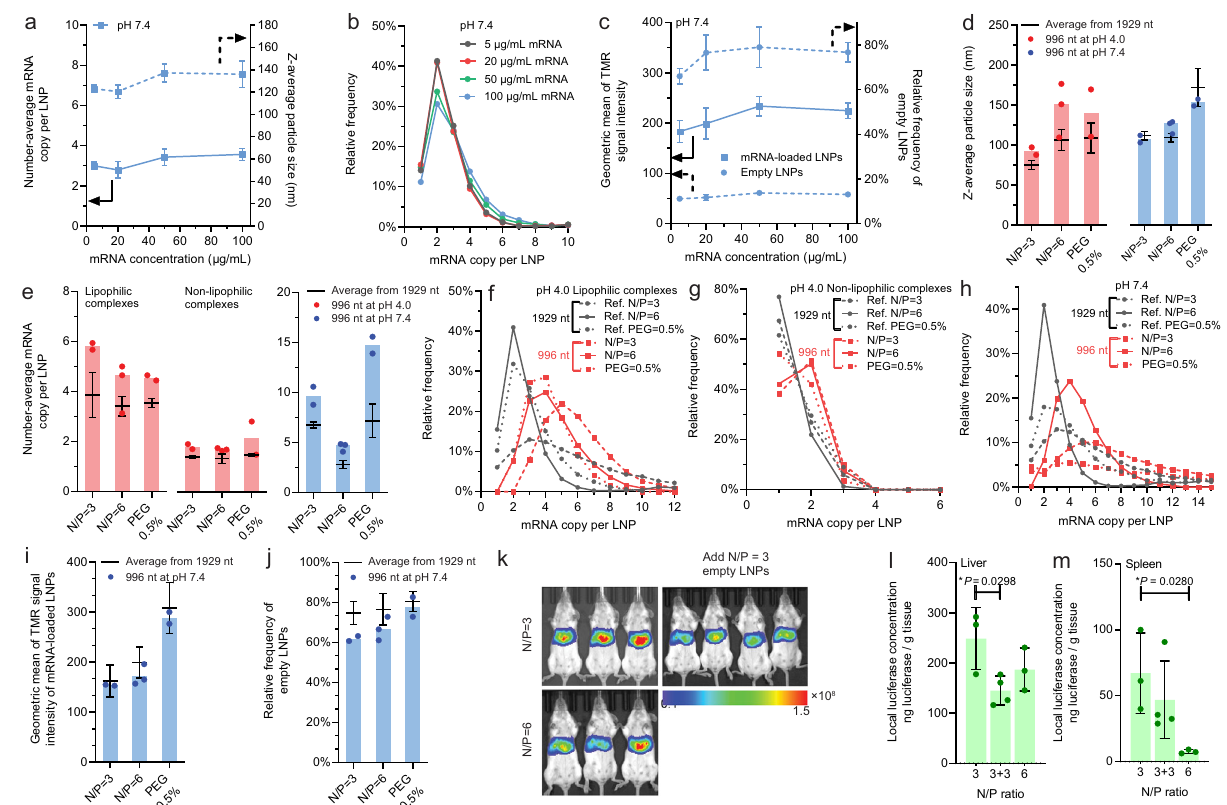
Fig. 7 | Effects of lipid and mRNA concentrations and mRNA size on payload capacity and distribution, and effect of empty LNPs on mRNA delivery ef fi - ciency. a – c The effect of mRNA (and lipids) concentration on ( a ) the z-average particlesizeandnumber-averagemRNApayload( n =3,exceptfor20 μ g/mLwhere n =6); b the payload distribution; and c the relative helper lipid content in mRNA- loadedoremptyLNPs,aswellasthefractionofemptyLNPsatpH7.4( n =3,except for 20 μ g/mL where n =6). d – j Effect of mRNA size (996 nt vs. 1929 nt) on d the z-average particle size, e the number-average mRNA payload, f the payload dis- tributionatpH4.0forlipophiliccomplexes; g